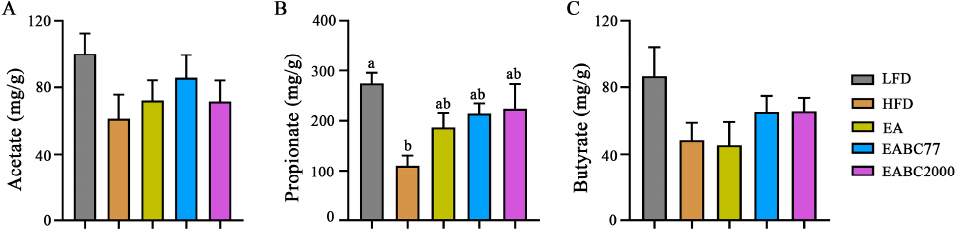
Figure 3. Effect of jointly consuming Weizmannia coagulans BC2000 and ellagic acid on short-chain fatty acid of mice. ( A ) Acetate; ( B ) propionate; ( C ) butyrate. Different lowercase letters above the bars represent significant inter-group differences by Tukey’s test or the Kruskal–Wallis test ( p < 0.05). n = 6 in each group. LFD: low-fat-diet group; HFD: high-fat-diet group; EA: EA intervention group; EABC77: EA + Weizmannia coagulans BC77 intervention group; EABC2000: EA + Weizmannia coagulans BC2000 intervention group.